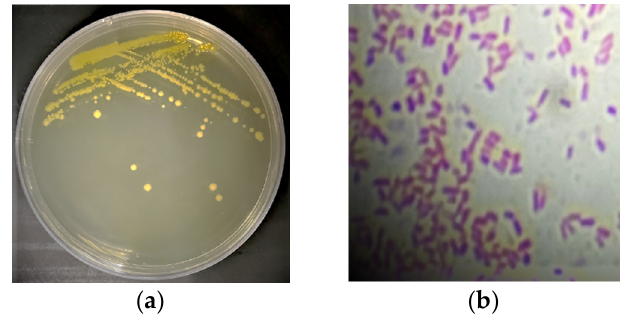
Figure 1. ( a ) A morphological characterization of Pantoea vagans colony growth, ( b ) a light micrograph of Gram stain of Pantoea vagans showing Gram-negative bacilli bacteria. The micrograph was taken using 100× objective lens, total magnification of 1000×.